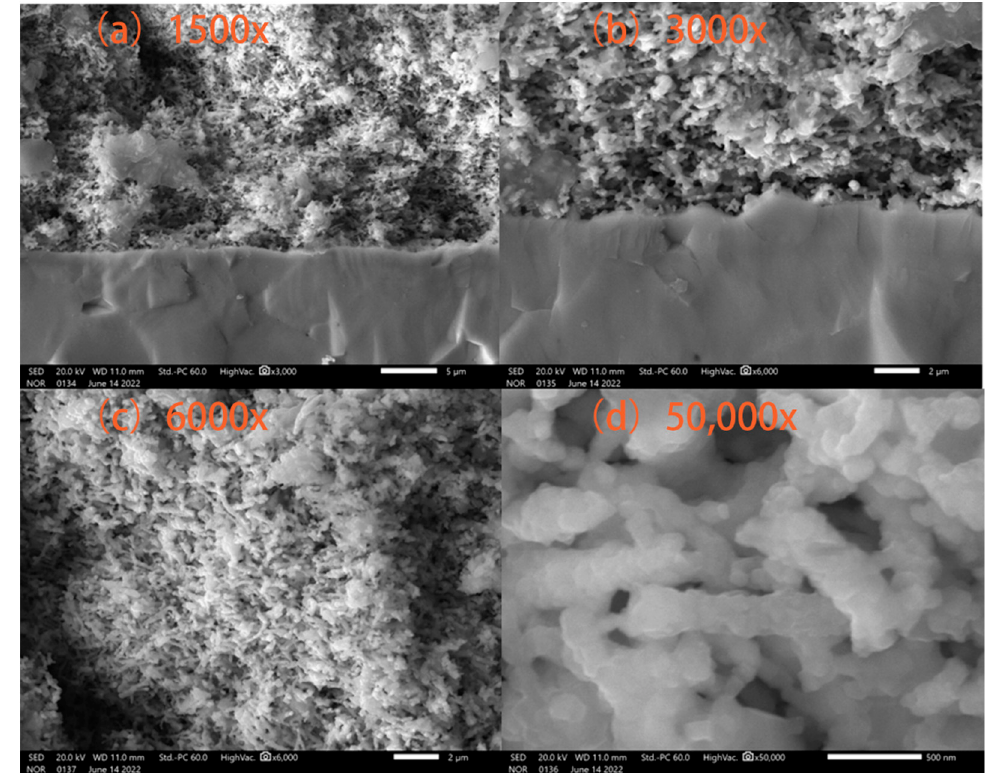
Figure 4. SEM images of SFMO nanofibers on the LSGM electrolyte after cell calcination: ( a , b ) the interface between the electrode and the electrolyte; ( c , d ) SFMO electrode. Table 1. The area-specific resistances for SFMO symmetrical cells.